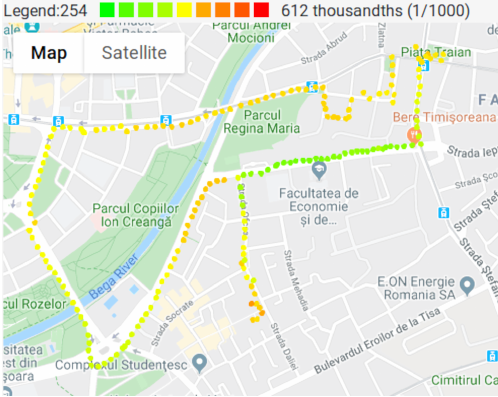
Figure 11. Humidity